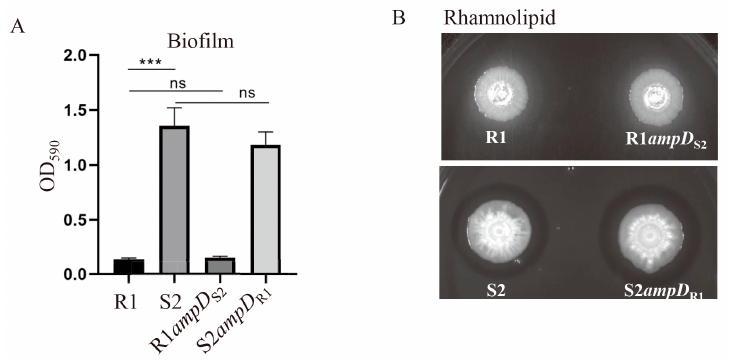
Figure 5. Biofilm formation ( A ) and rhamnolipid production ( B ) by the indicated bacterial strains. ( A ) Cultures of the indicated P. aeruginosa strains were diluted 50-fold in L-broth and incubated in each well of a 96-well plate for 48 h at 37 °C. The biofilm in the well was stained with 0.25% crystal violet, dissolved in 200 µL of eluate, and subjected to measurement at OD 590 . ns, not significant; *** p < 0.001 by Student’s t test. ( B ) Production levels of rhamnolipids were determined on theplate; 1 µL culture of the indicated P. aeruginosa strain was plotted onto the plate and incubated at 37 °C for 24 h and then at room temperature for 72 h. The presence of a halo ring around the bacterial colony indicates the production of rhamnolipids.